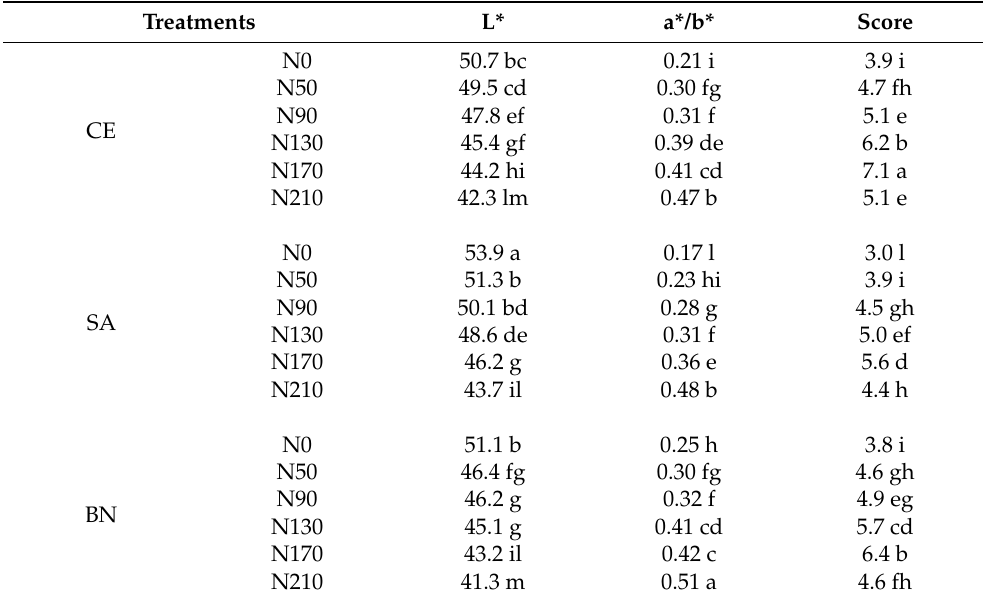
Table 4. The effect of Locations x N fertilization rates and Years x Locations on L*, a*/b*, and scores (by expert evaluators) of cured leaves. For the explanation of the index, see Materials and Methods